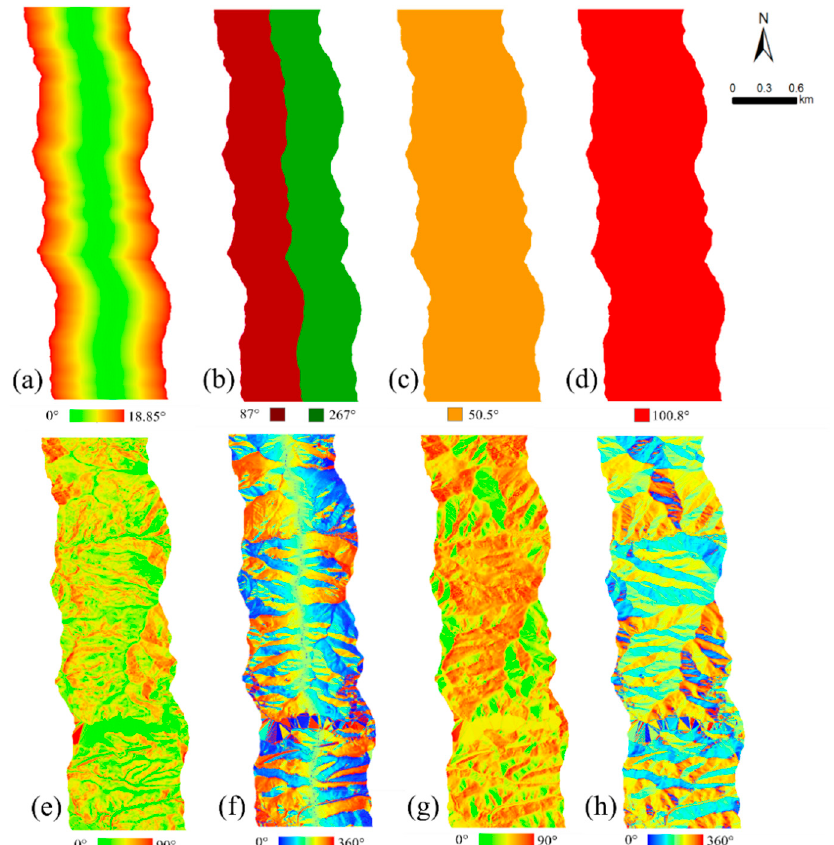
Figure 4. Local viewing and illumination geometry for a hyperspectral sample extracted from the first (i.e., easternmost) flight-line (06/04/2014). ( a )–( d ) respectively show the theoretical view zenith angle (VZA), view azimuth angle (VAA), solar zenith angle (SZA), and solar azimuth angle (SAA) under the assumption of flat topography; ( e )–( h ) instead, respectively, show local VZA, local VAA, local SZA, and local SAA for the surveyed area.